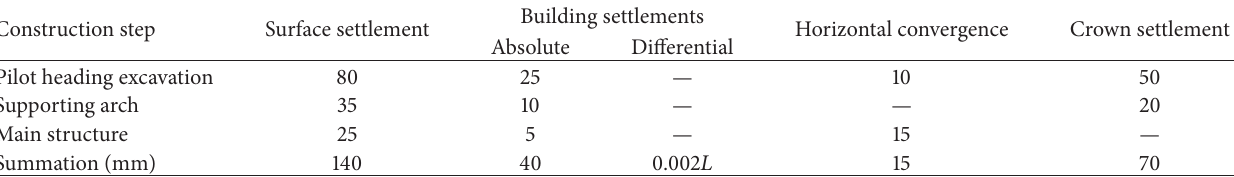
Table 3: Management critical value for settlement of ground surface and building.